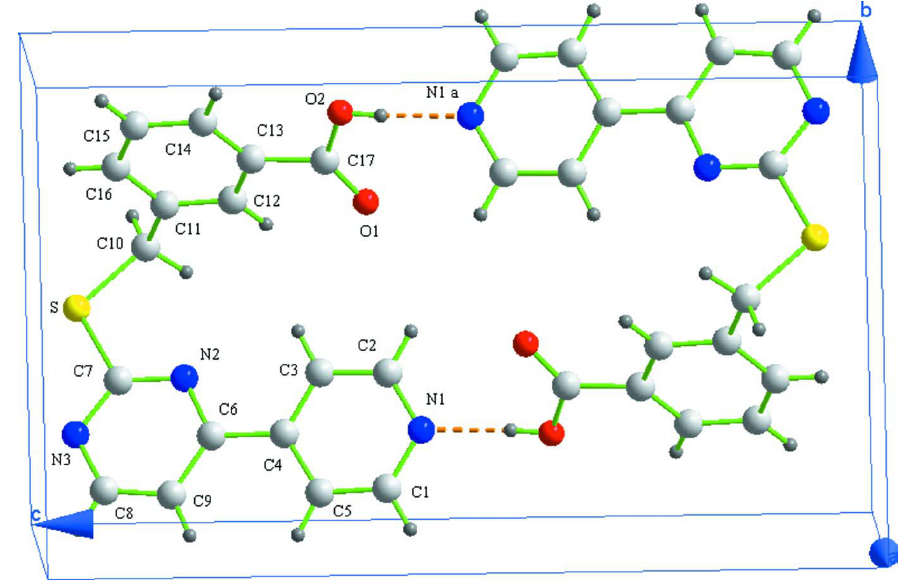
Figure 2 The hydrogen bonded dimer with O—H···N interactions (dotted lines) [symmetry code: - x + 2, - y + 1, - z +